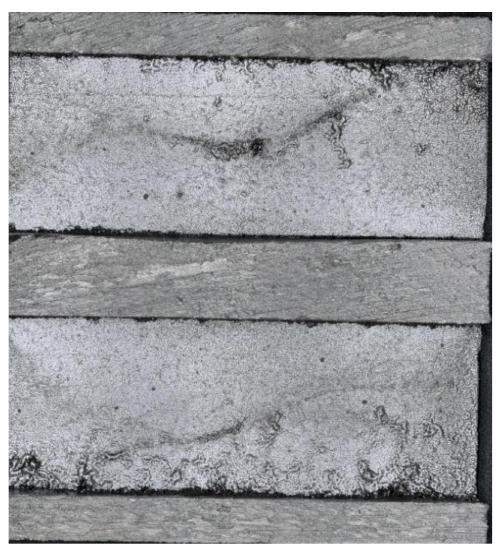
Figure 13. Surface quality CB20B, magnification 10 × .